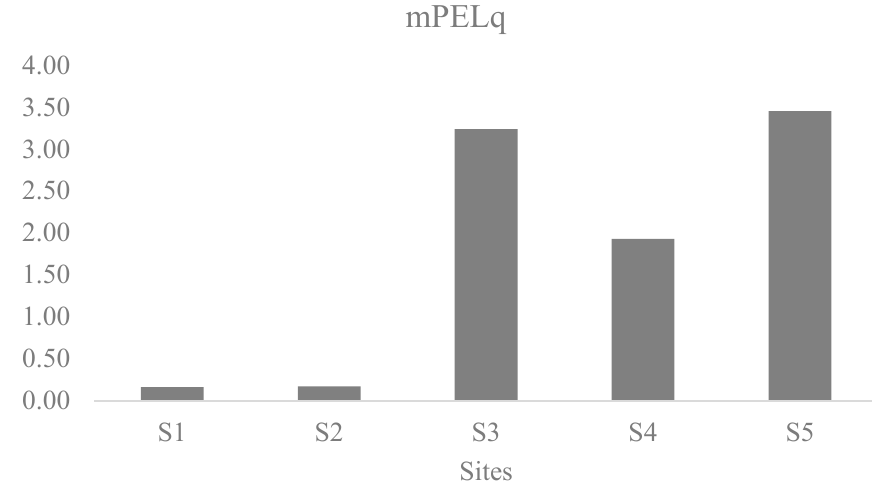
Figure 3. m PEL quotient across the sites. mPELq = mean probable effect limit quotient.